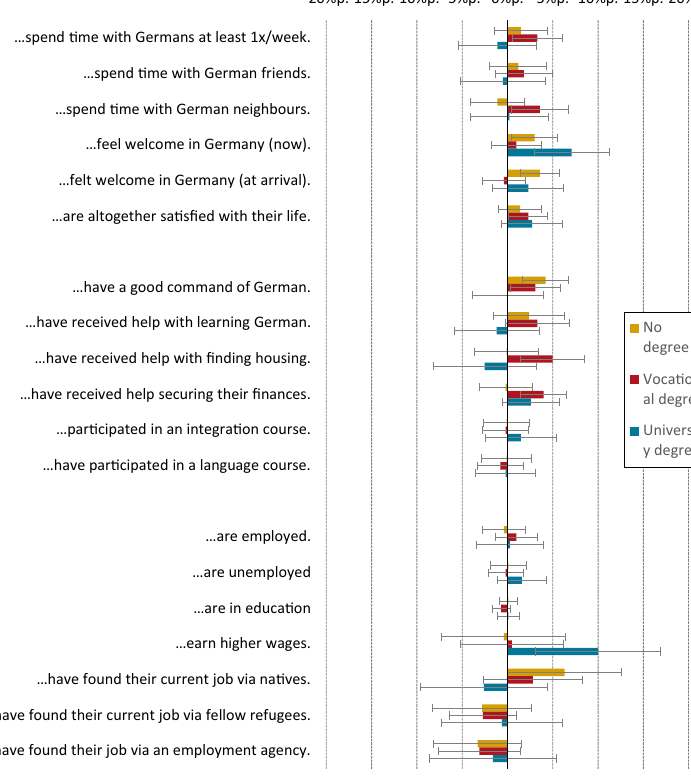
Figure 5: Relationship between local civic engagement and indicators for social integration by education. Source: IAB-BAMF-SOEP Refugee Survey 2016 – 2019, own